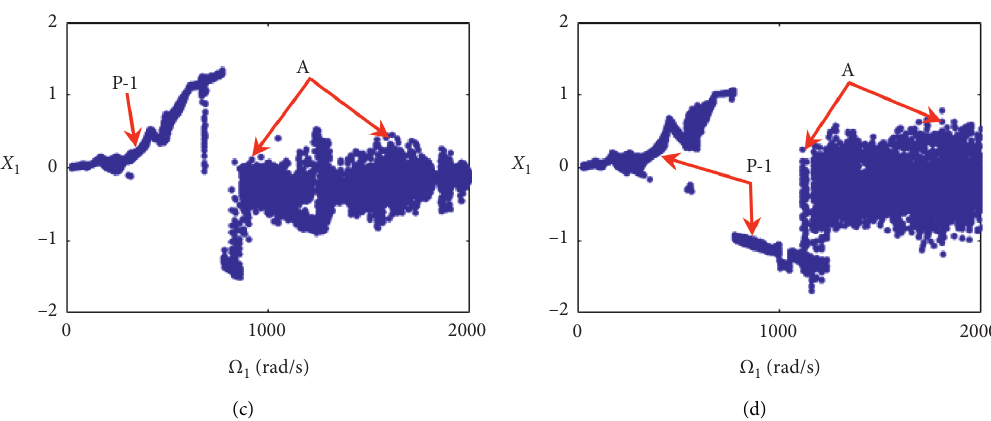
Figure 4: Bifurcation diagrams of the nondimensional displacement in x -direction X � 20 μ m. Note that P-1 means the periodic one motion, P-2 means the periodic two motion, and A means the aperiodic motion. c 0